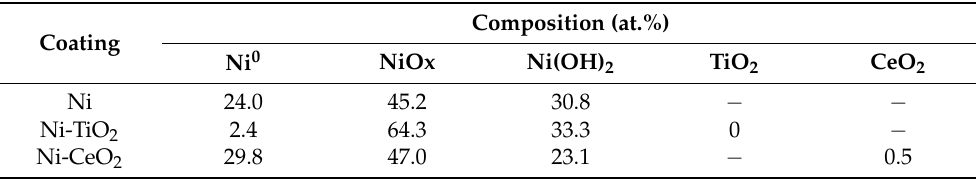
Table 9. Composition (at.%) of Ni, Ni-CeO 2 and Ni-TiO 2 composite coatings after immersing in 0.5 M NaCl for 3.5 months by XPS analysis.